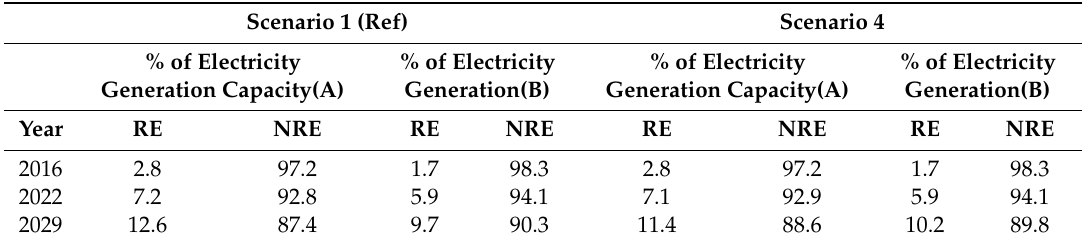
Figure 19. Profit change amount (KRW / MWh) and rate (%) of: ( a ) AP segment (M10); ( b ) IL segment (M1); ( c ) IF segment (M18); ( d ) RS segment (M5) (compared to SC1). Table 9. Comparison of the ratio of RE / NRE by scenario (SC1 and